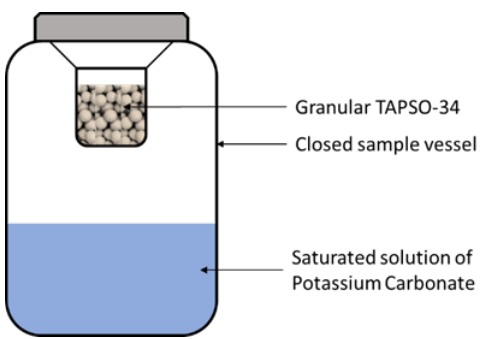
Figure 4. Pre-treatment of the adsorbent at defined humidity.